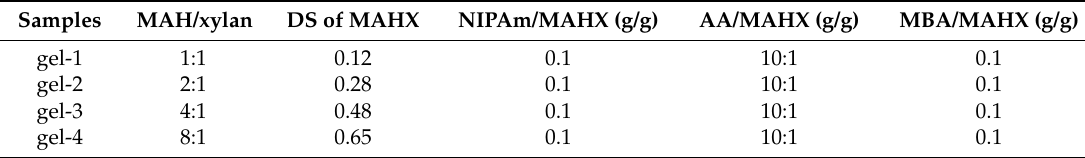
Table 1. Degree of substitution (DS) of maleic anhydride-modified xylan (MAHX) and the preparation conditions of MAHX-based